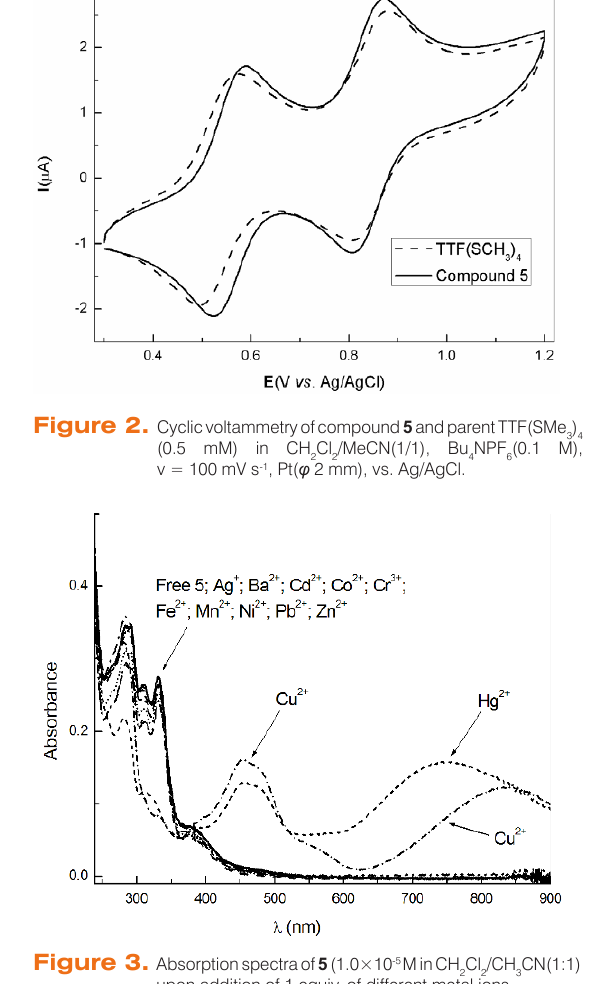
upon addition of 1 equiv. of different metal ions.